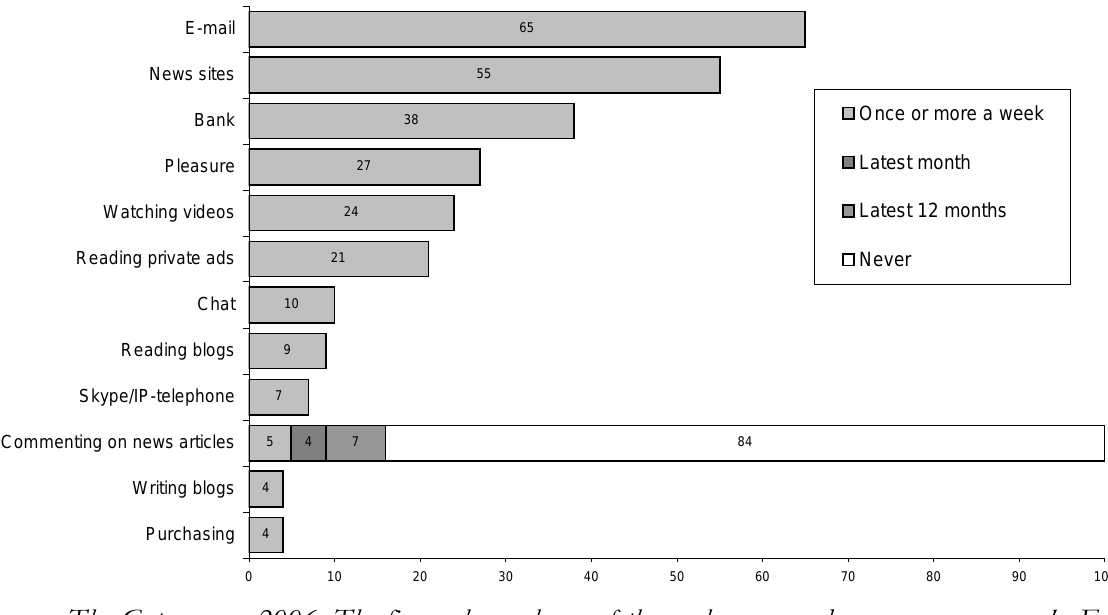
Source: The Gota-survey 2006. The figure shows shares of those who answered once or more a week.